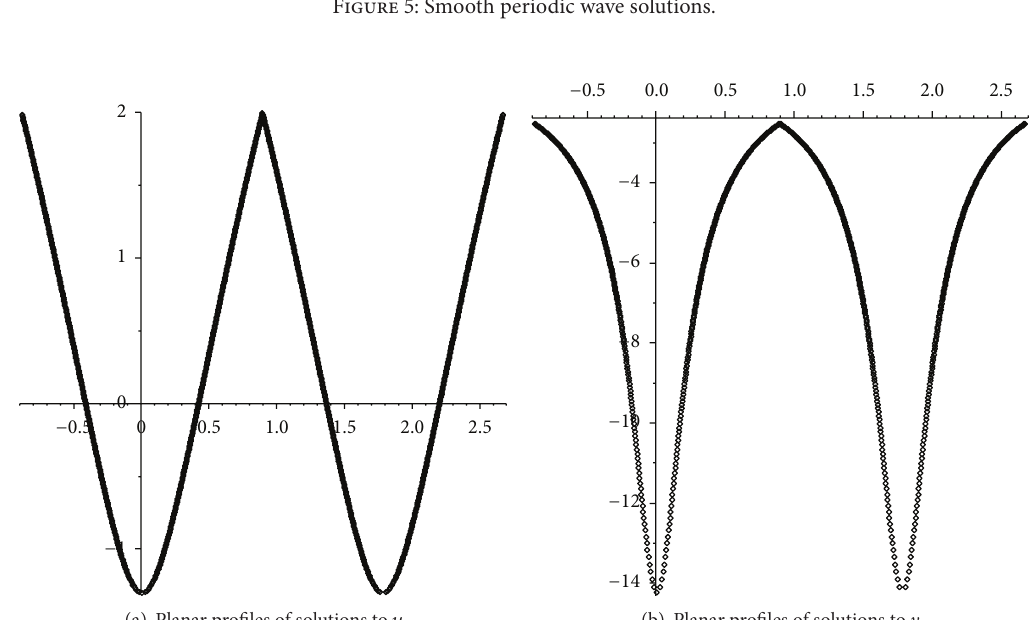
Figure 6: Peaked periodic cusp wave